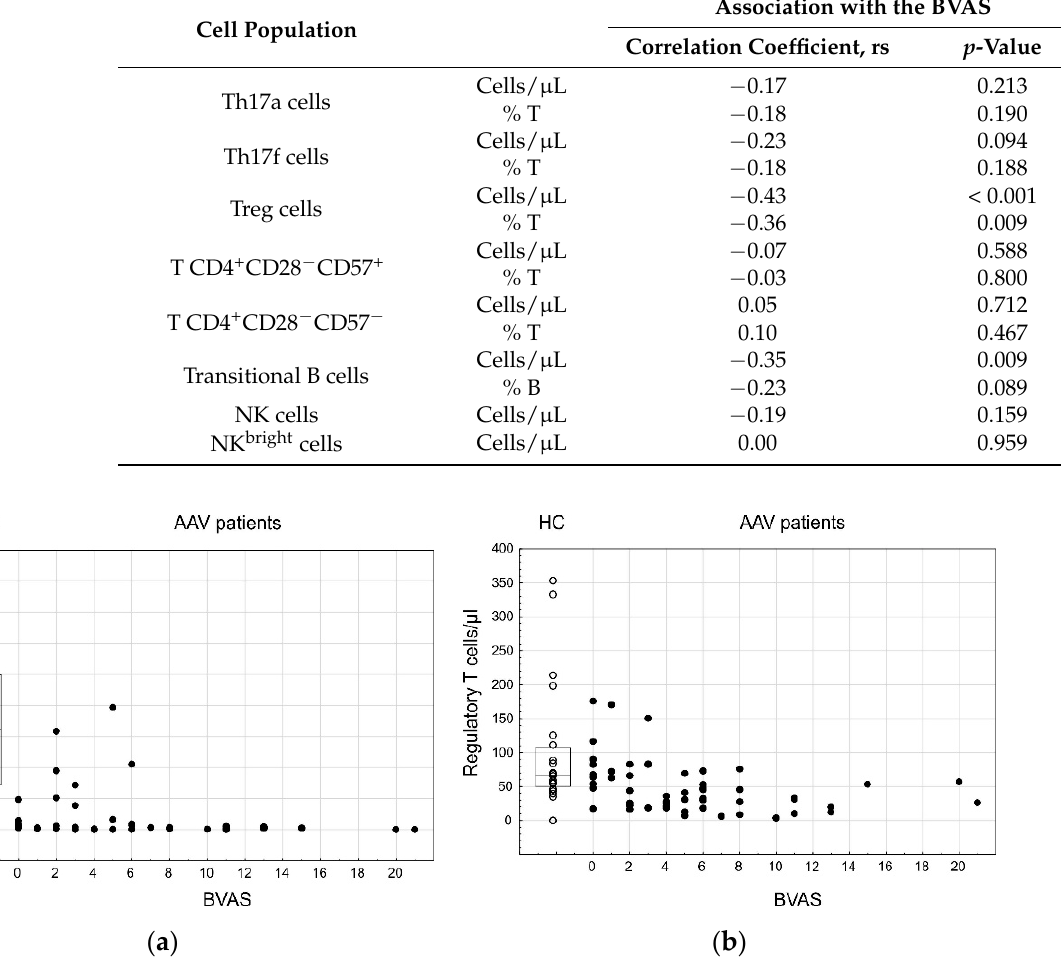
Figure 4. Transitional B cells and regulatory T cells and their relation to the AAV disease and its activity; ○ —HC, box—IQR, line—median, ● —AAV. ( a ) Transitional B cells—HC vs. AAV, p < 0.001; correlation with the BVAS, rs = − 0.35, p = 0.009. ( b ) Regulatory T cells ― HC vs. AAV, p < 0.001; correlation with the BVAS, rs = − 0.43, p < 0.001. Table 6. Relationship between the AAV-related immune fingerprint cell populations and the dis- ease activity in the patients group.